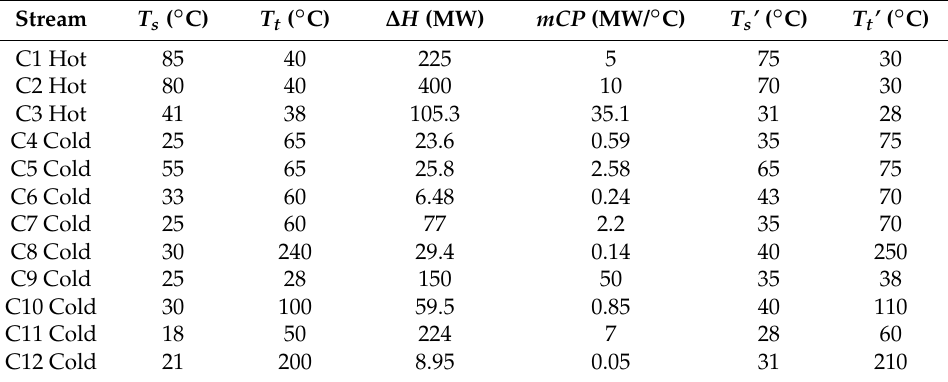
Table 3. Stream data for Industrial Plant C with ∆ T min, pp 20 ◦ C [19].